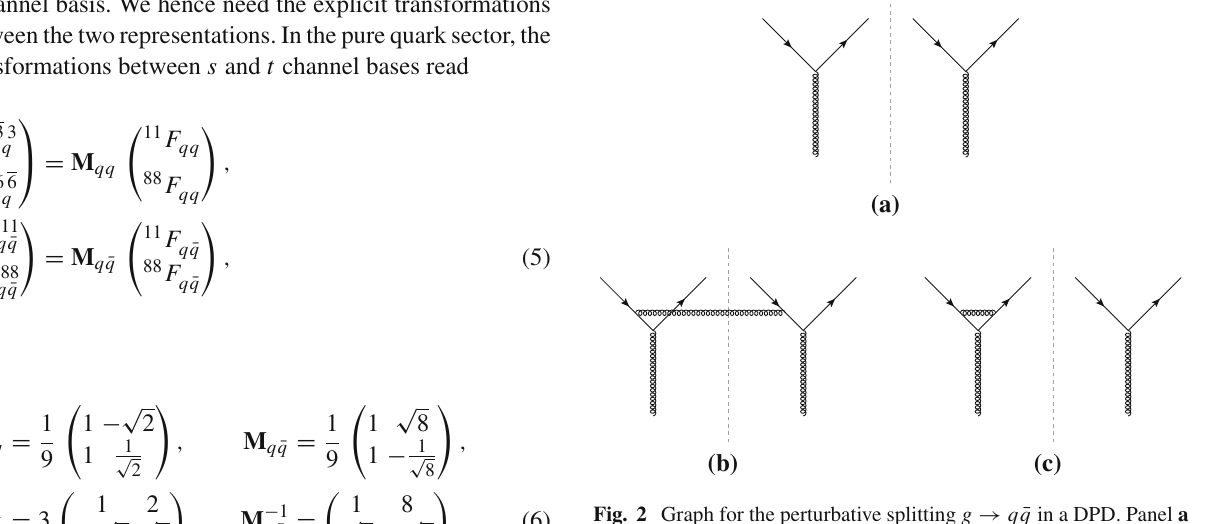
Fig. 2 Graph for the perturbative splitting g → q ¯ q in a DPD. Panel a shows the LO graph, and panels b and c are examples of real and virtual NLO graphs. The dashed vertical line indicates the final state cut of the scattering process in which the distributions appear